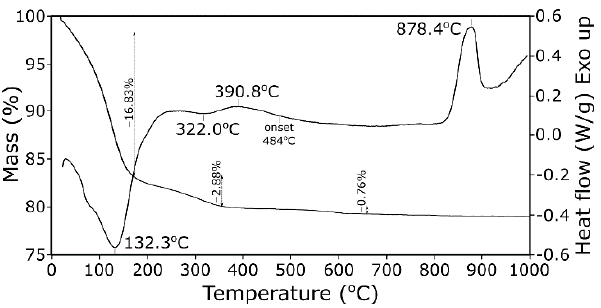
Figure 2. TG-DSC curves of zeolite Na-A.